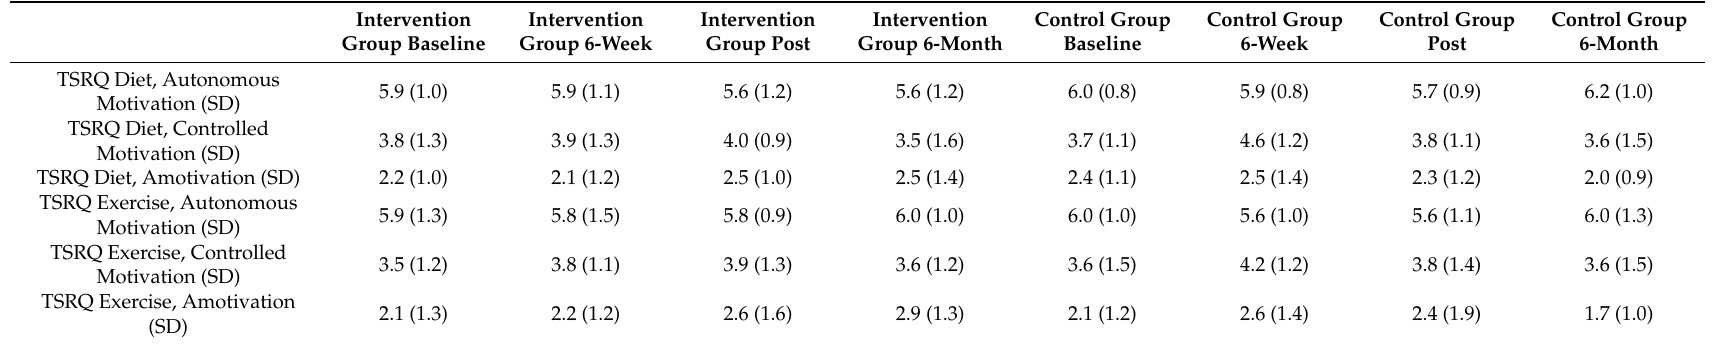
Table 6. TSRQ Variables for Intervention and Control Groups, at Baseline, Mid Intervention, Post-Intervention, and 6-Month